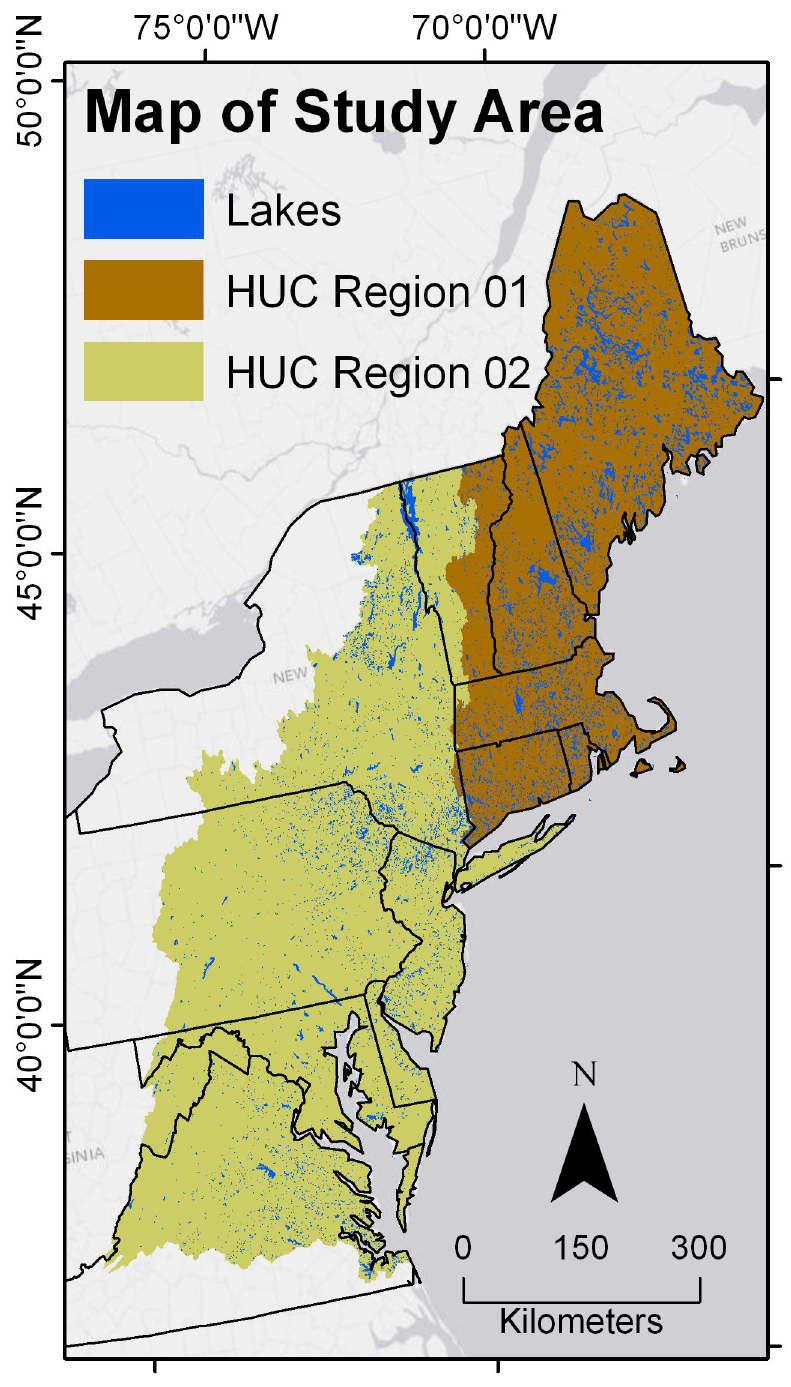
Figure 1. Map of the study area. Shown are the locations of the lakes within Hydrologic Unit Code (HUC) regions 01 (New England) and 02